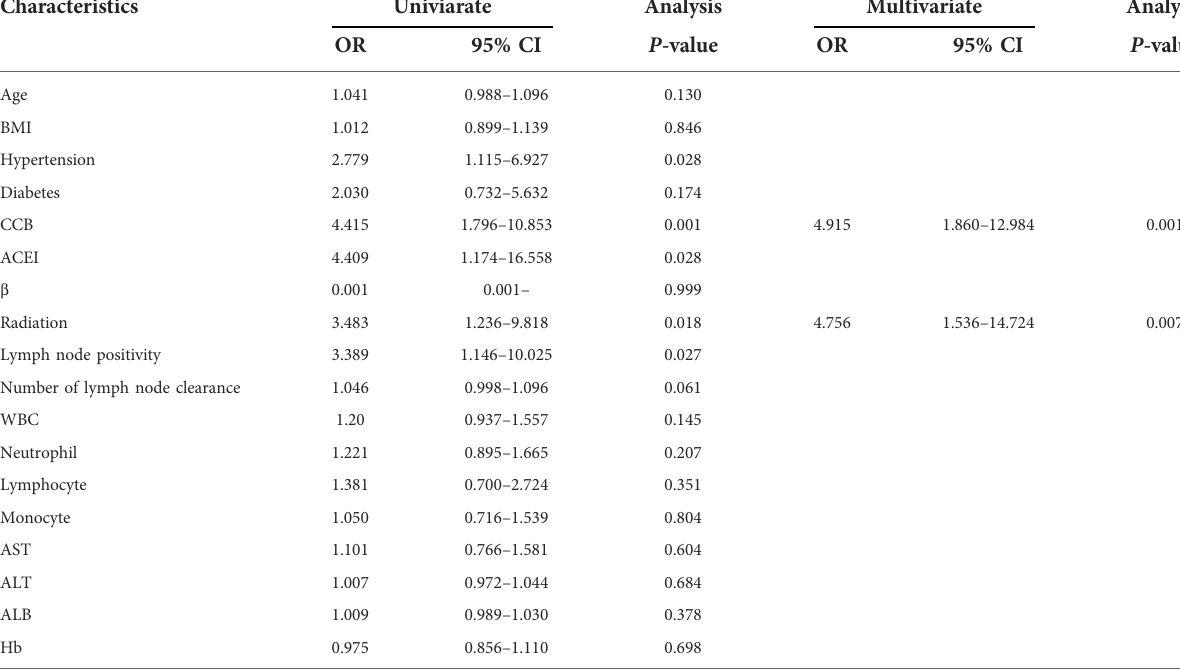
TABLE 4 Univiarate and multivariate analysis of endometrial carcinoma for lymph cystis.